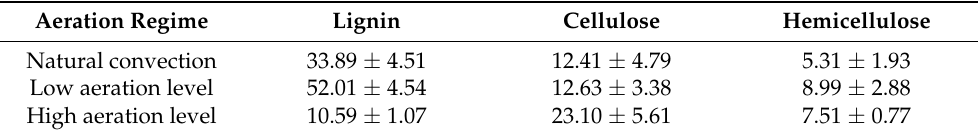
Table 2. Degradation percentages of lignin, cellulose, and hemicellulose for T. versicolor cultivated on a medium based on agro-industrial waste on the 14th day of solid-state fermentation in a fixed-bed pilot-scale bioreactor with natural convection and two levels of forced